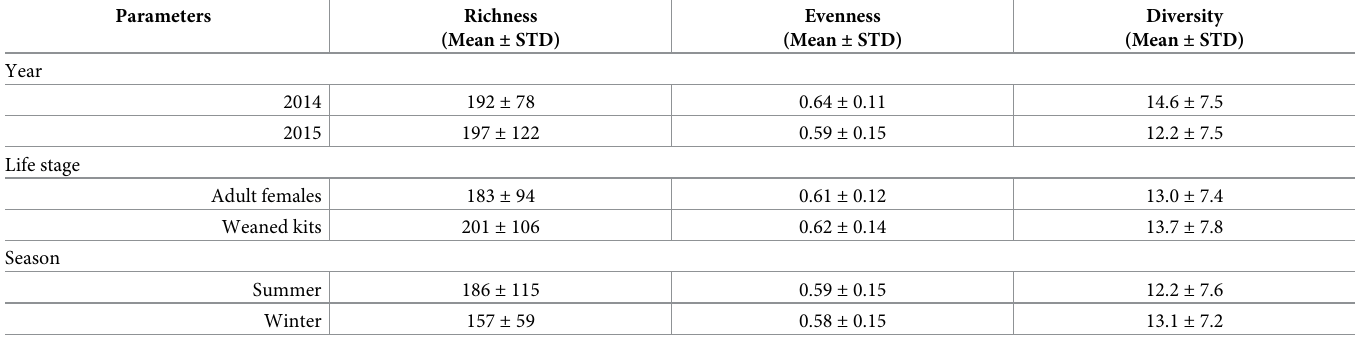
Table 4. Alpha diversity indices (Chao 1: Richness; Shannon: Evenness; Inverse Simpson’s: Diversity) observed in the feces of commercial mink by year (n = 332), season (n = 117), and life stage (n = 332). Samples were obtained from 43, 46, and 39 farms in 2014, 2015, and 2016, respectively.